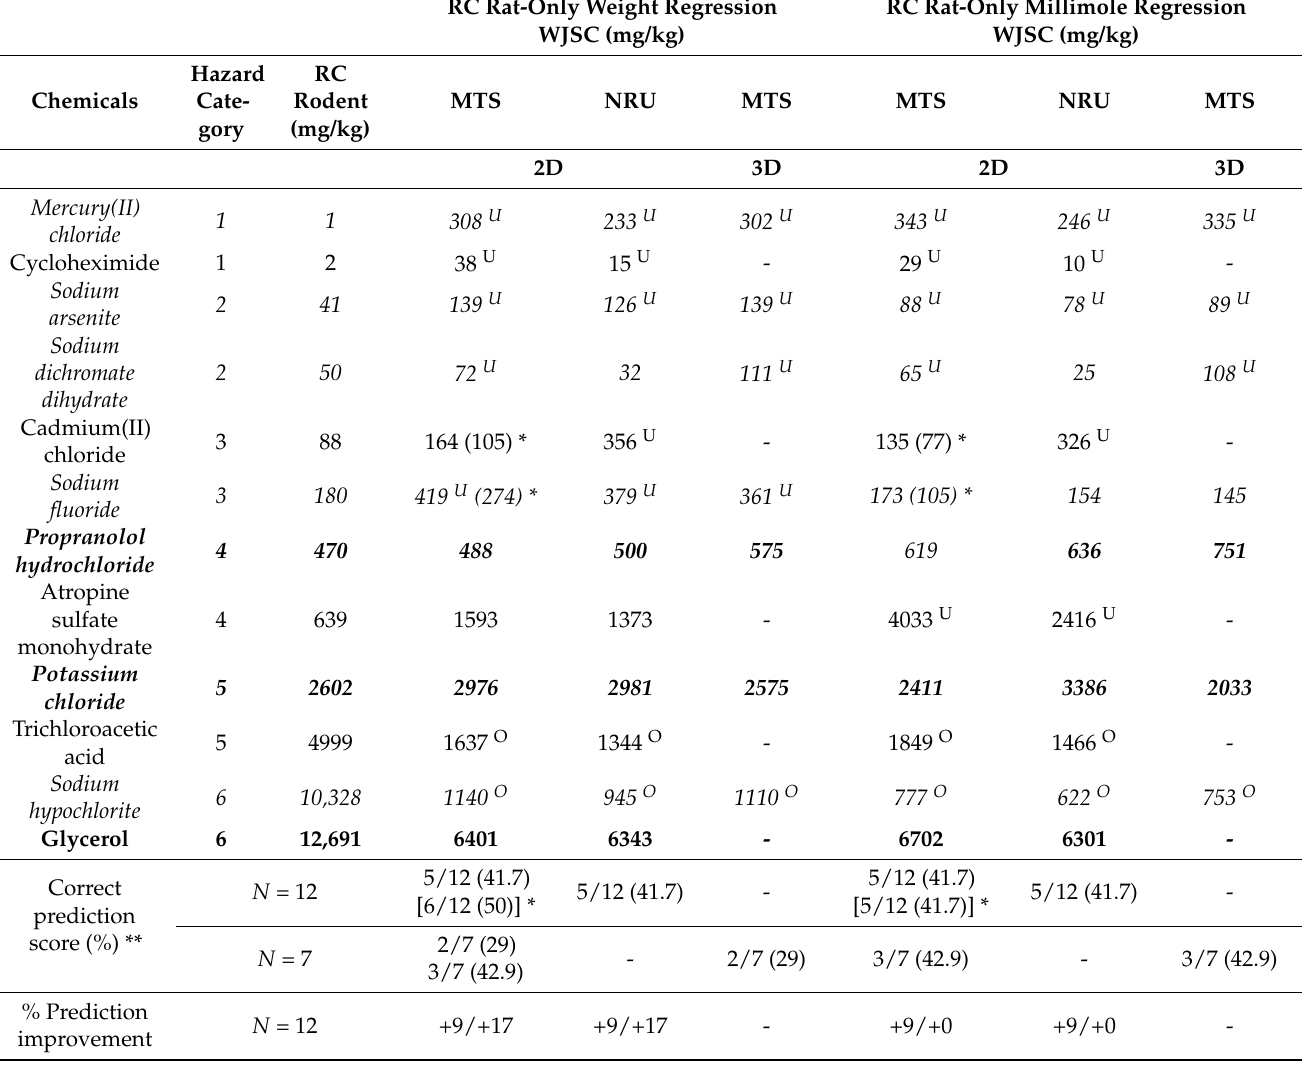
Table 3. Toxicity prediction outcomes as determined by MTS and NRU assays on WJSCs in two- (2D) and three-dimensional (3D) culture